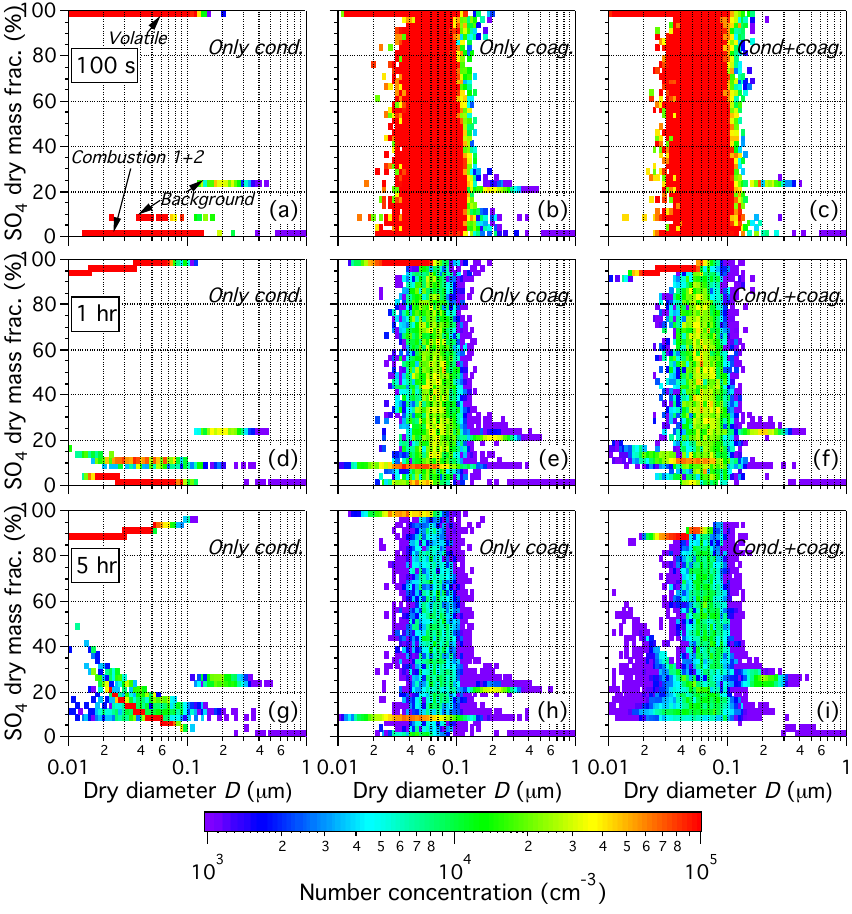
(D, w) after 100s, 1h and 5h of simulation for the base case. The two-dimensional 4 , dry